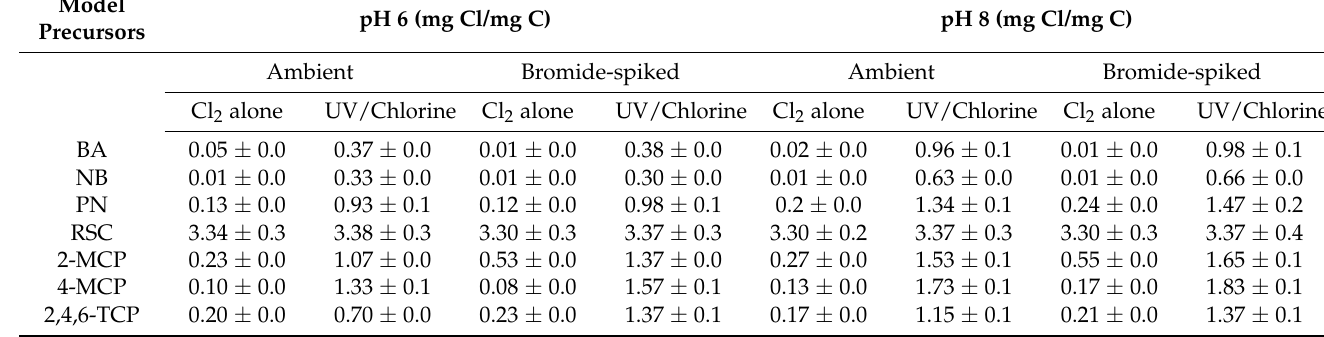
Table 2. Chlorine decay of the seven model compounds during the 60 s pre-oxidation under the following conditions: Chlorine dose = 10 mg Cl 2 /L, pH = 6.0 or 8.0, [model benzene precursors] 0 = 3 mg-C/L,